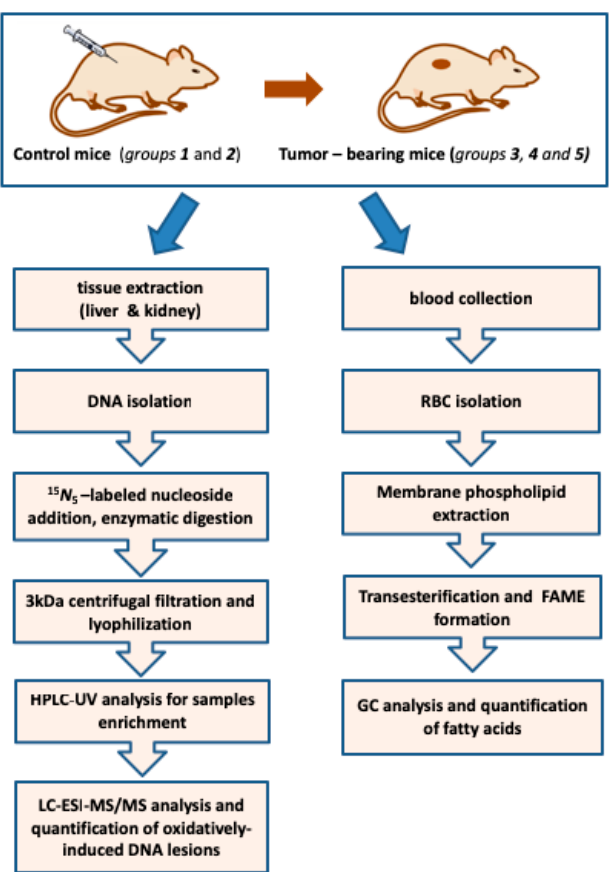
Figure 1. Flow chart for parallel analysis and quantification of oxidatively-induced DNA lesions in tissues and membrane fatty acid moieties in erythrocytes of SCID mice; Group 1 : 4-weeks old; Group 2 : 17-weeks old; Group 3 : 4-weeks old; Group 4 : 5-weeks old; Group 5 : 17-weeks old.